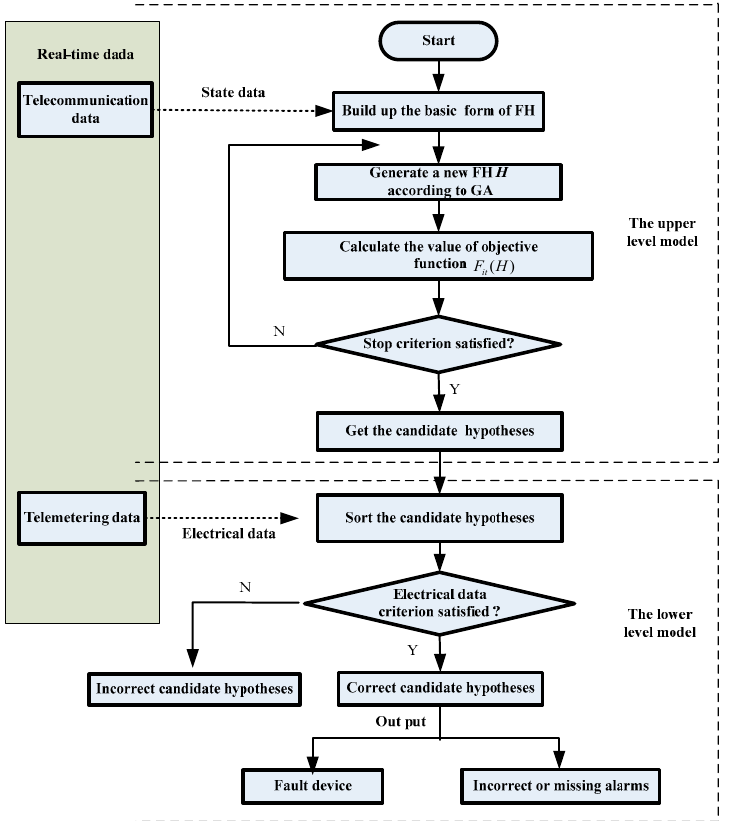
Figure 2. The framework of the developed fault location model.